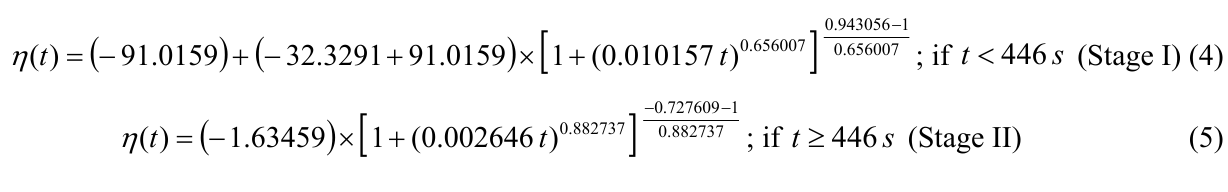
Figure 5. Comparative plot of LPFG-RV-measured viscosity and predicted viscosity.